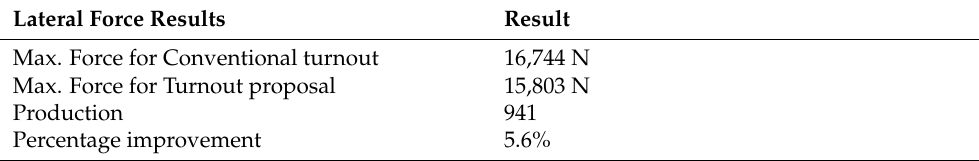
Table 7. Results obtained for the maximum lateral force of the right front wheel of the